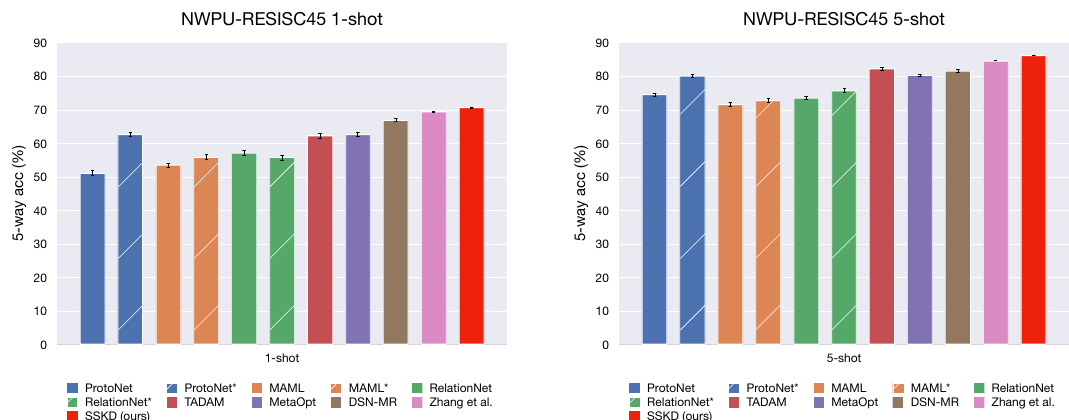
Figure 11. The few-shot classification performance (with 95% confidence intervals) for the NWPU-RESISC45 dataset, the striped bars indicate the re-implementation of approaches with a Resnet-12 backbone.